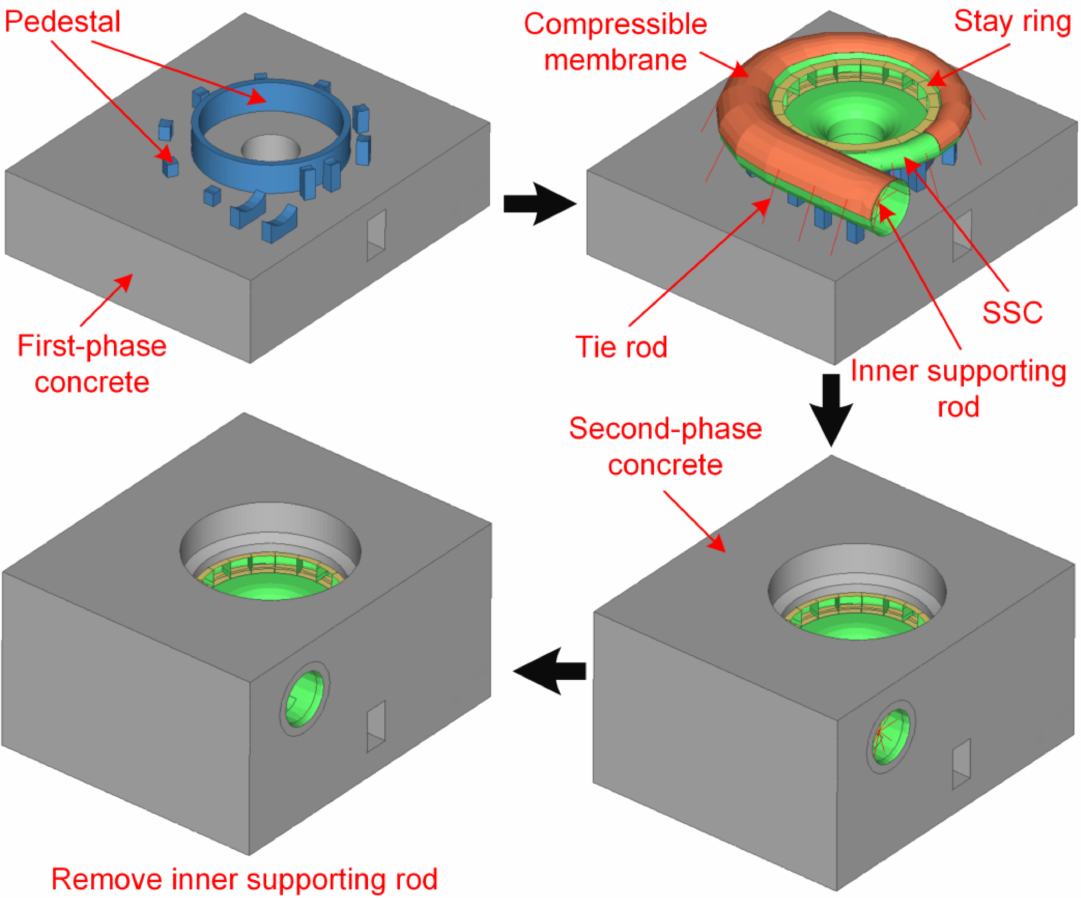
Figure 2. Standard construction procedure of M-type